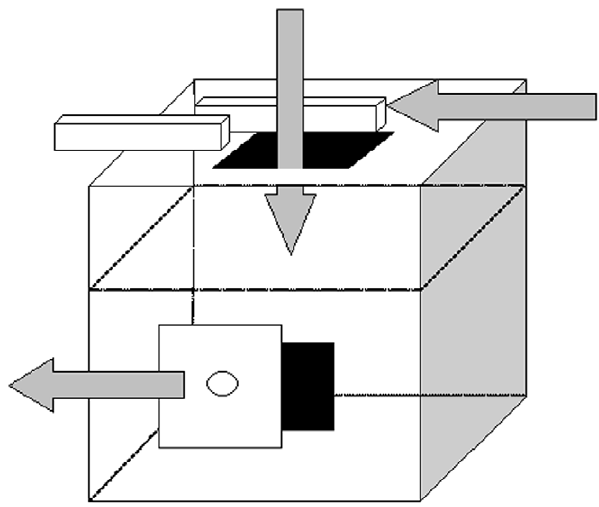
Figure 1. Illustration of principal task components. (1) Remove bolts. (2) Irrelevant tool insertion, tool strikes barrier within box 3 times. (3) Open door in order to retrieve the reward. The inefficient technique included all 3 task components whereas the efficient technique comprised component 3 only.